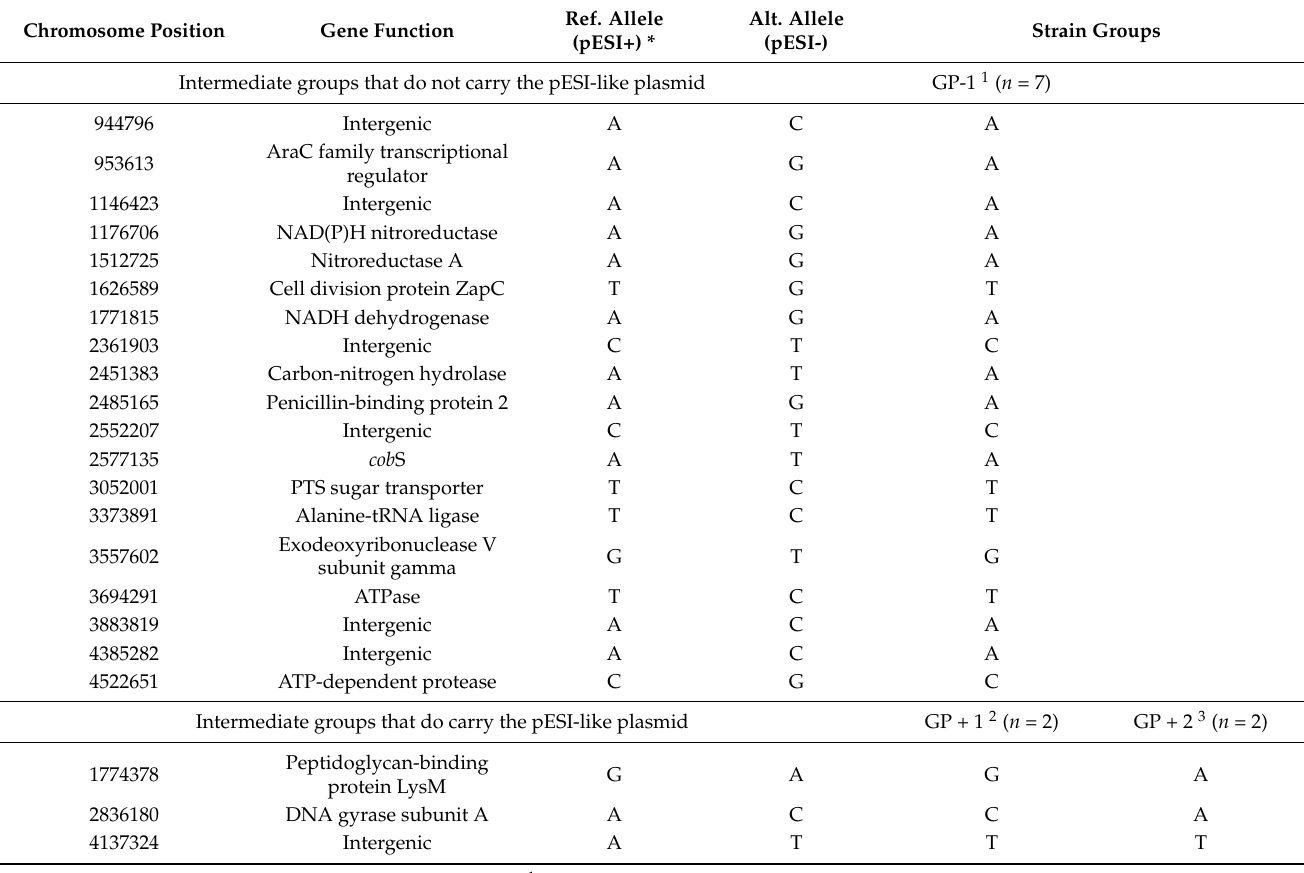
Table 1. Overview of single-nucleotide polymorphism differences in intermediate Salmonella Infan- tis